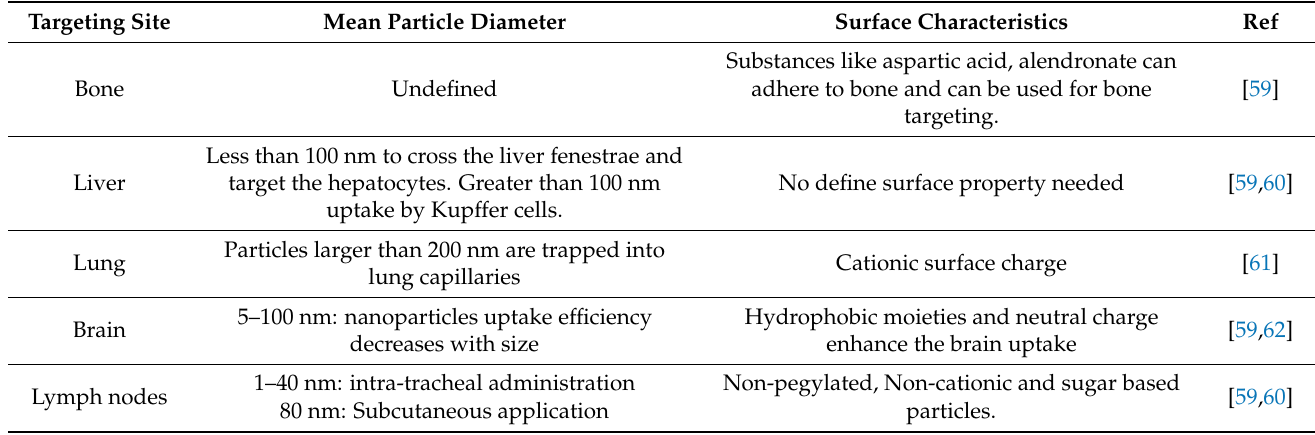
Table 1. Prerequisite of DNA nanostructures to fulfill the mean particle diameter for specific organ targeting. Targeting Site Mean Particle Diameter Surface Characteristics Substances like aspartic acid, alendronate can Bone Undefined adhere to bone and can be used for bone Less than 100 nm to cross the liver fenestrae and Liver target the hepatocytes. Greater than 100 nm uptake by Kupffer